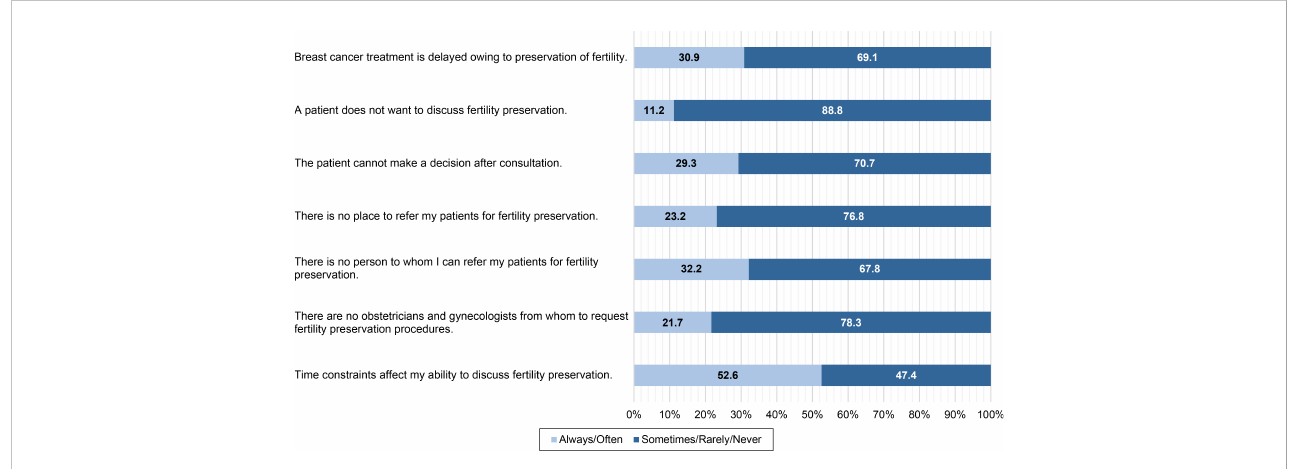
FIGURE 2 Barriers to discussing fertility issues.